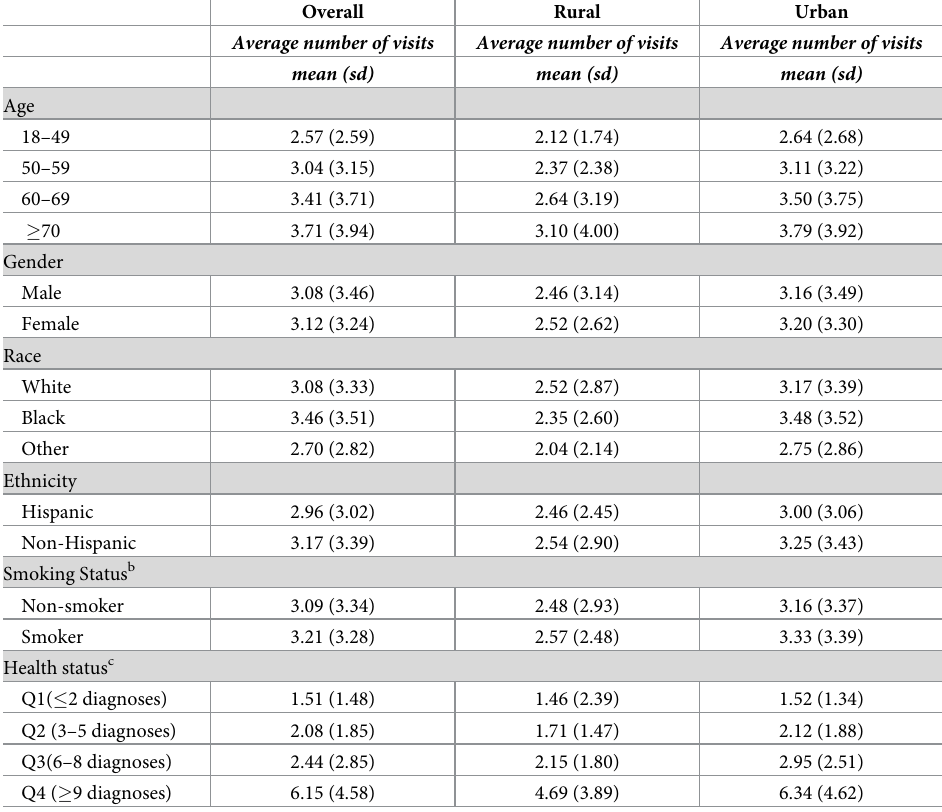
Table 3. Healthcare utilization across patient characteristics in rural vs. urban clinics a